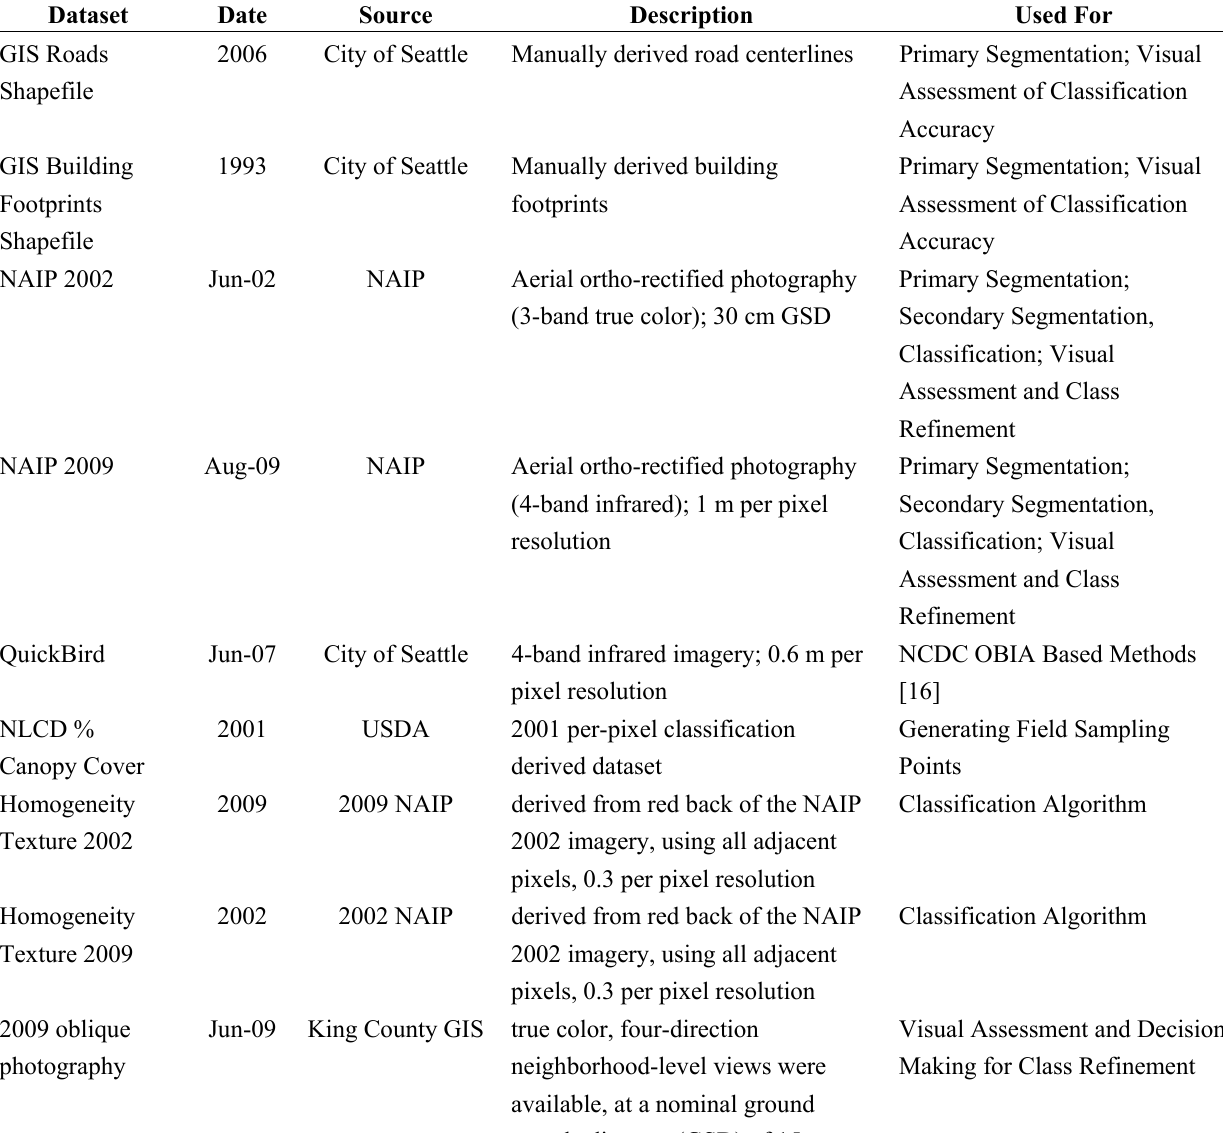
Table 2. Summary of